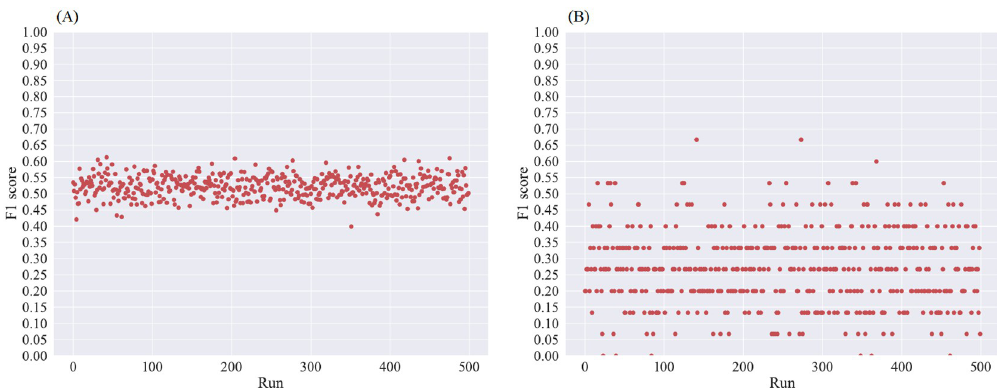
Fig 8. F1 score results of the trained and tested random forest classifier using scores calculated with k = 7 clusters. (A) Results for the 500 runs using the clinical label as ground truth. (B) Results for the 500 runs using the FIOAS label as ground